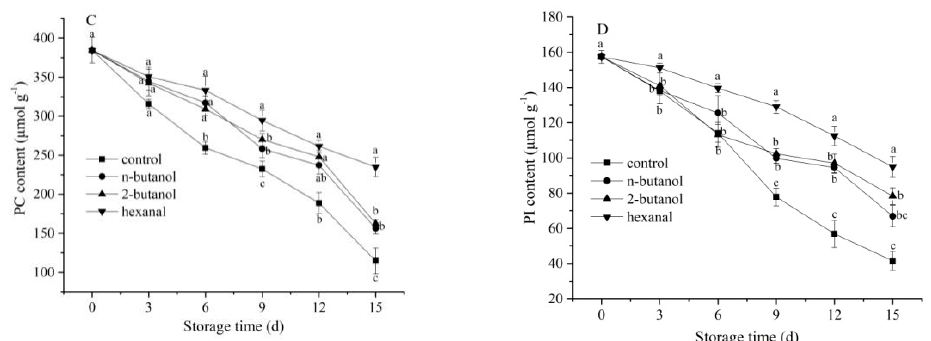
Figure 4. Effect of phospholipase D inhibitors treatment on cell membrane PA content ( A ), DAG content ( B ), PC content ( C ), and PI content ( D ) of postharvest banana fruit in response to mechanical wounding stress. The vertical bars in each mean indicate the standard error ( n = 3). Different letters among treatments at the same time point indicate significant differences ( p < 0.05).